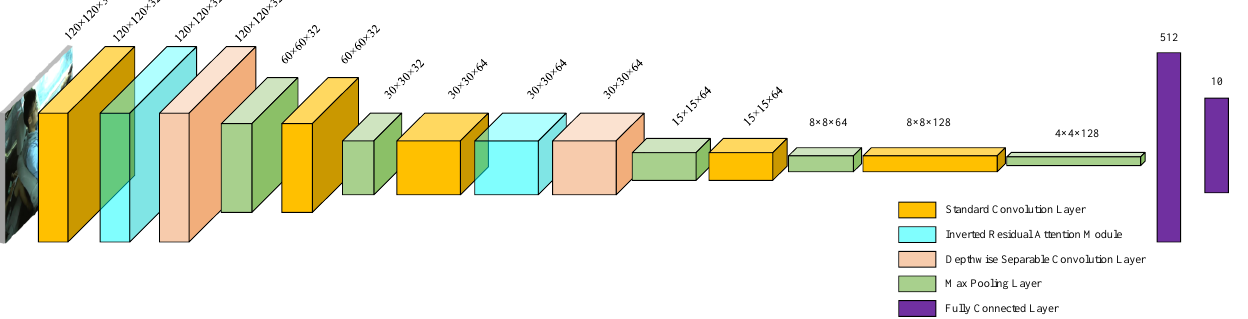
Figure 4. Schematic of the Lightweight Attention-based network (LWANet). LWANet takes an image of size 120 × 120 × 3 as the input and produces a classification label as the output. The detailed structure of filter shapes and input and output shapes of each layer is shown in Table 1. Table 1. A list of detailed network architecture.